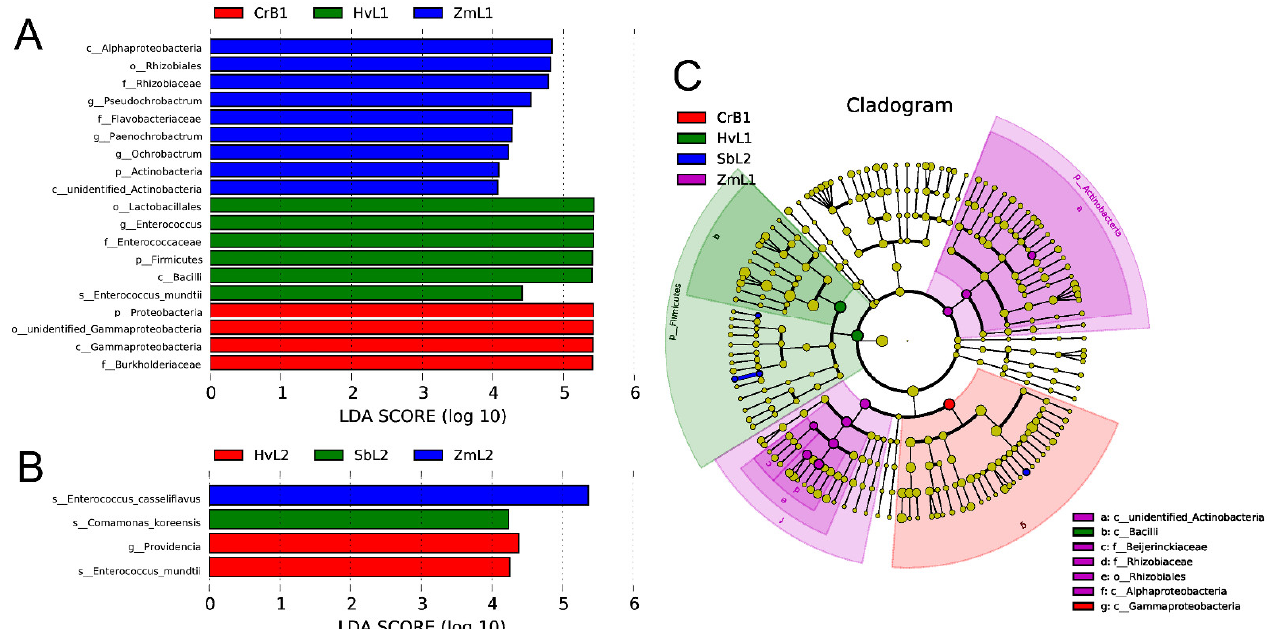
Figure 5. Linear discriminant analysis (LDA) of gut bacterial taxa in S. frugiperda larvae fed on leaves of different host plants. Taxa with LDA score (log 10) greater than four in ( A ) fifth and ( B ) sixth instar larvae. ( C ) LEfSe (LDA Effect Size) analysis showing significant differences in bacterial taxa at the level of phylum, class, order, family, and genus, from inside to outside. Small circles at different classification levels represent classifications at a particular level, and their diameters represent relative abundances. Nodes of different colors represent bacteria that were significantly enriched with the corresponding host. Significantly different biomarkers follow the group for coloring. Small yellow nodes indicate bacterial taxa that were not significantly different in guts of larvae fed on different